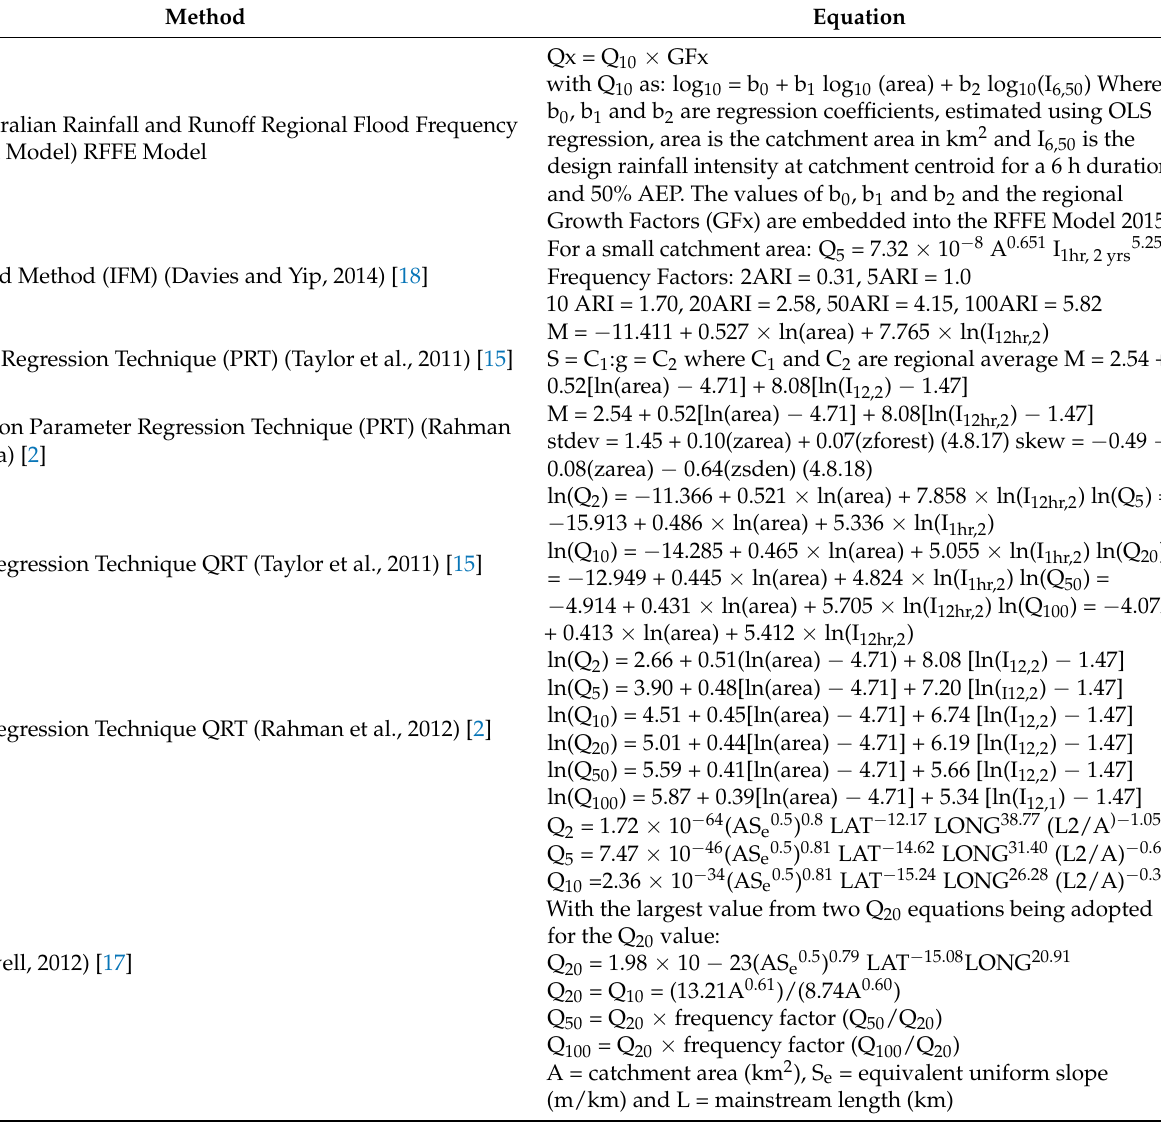
Table 1. Regional Flood Frequency Estimation methods applied to headwater